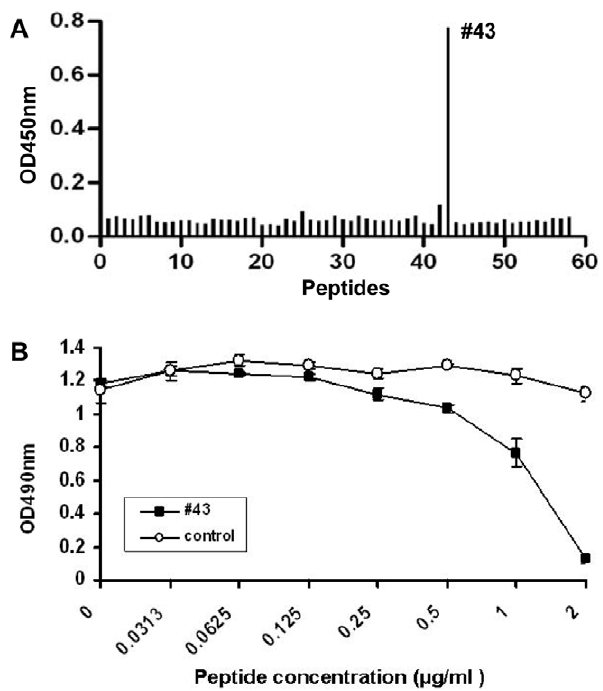
Figure 7. Neutralizing antibodies in the anti-VLP sera predom- inantly target an epitope located in the GH loop of VP1 protein. (A) Mapping of immunodominant B-cell linear epitopes within the VP1 protein. The pooled anti-VLP sera were analyzed by indirect ELISA for reactivity with a panel of 58 synthetic peptides covering the entire sequences of VP1. (B) Neutralization-inhibition by # 43 peptide. The anti-VLP sera were incubated with # 43 peptide or a negative control peptide (from HIV) at different concentrations for 1 hour at 37 u C. The peptide/antiserum mixtures were subjected to neutralization testing. Neutralization-inhibition by the peptides was determined using an MTT method. Data are means 6 SD of the OD490 readings of triplicate wells.